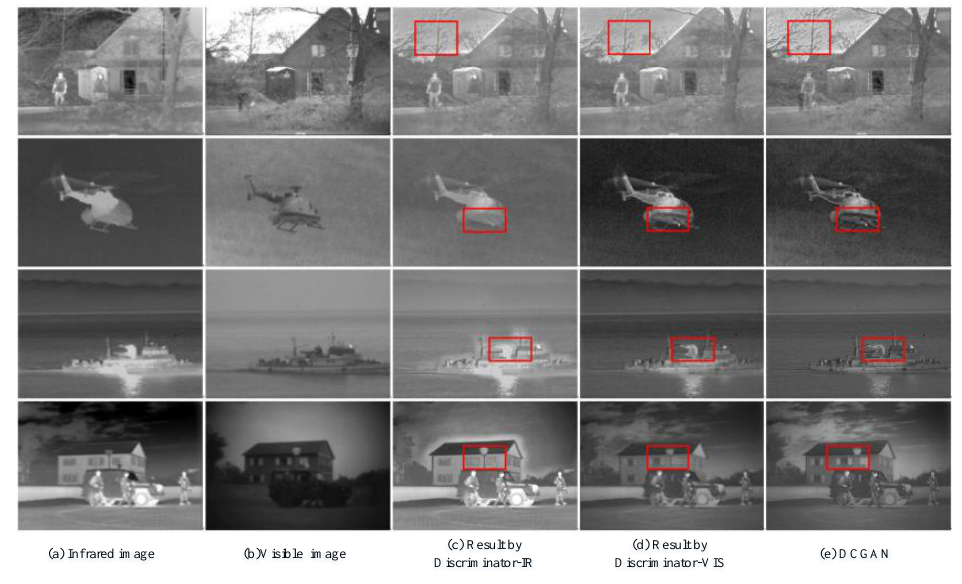
Figure 4. Subjective fusion results of infrared and visible images of four different scenes